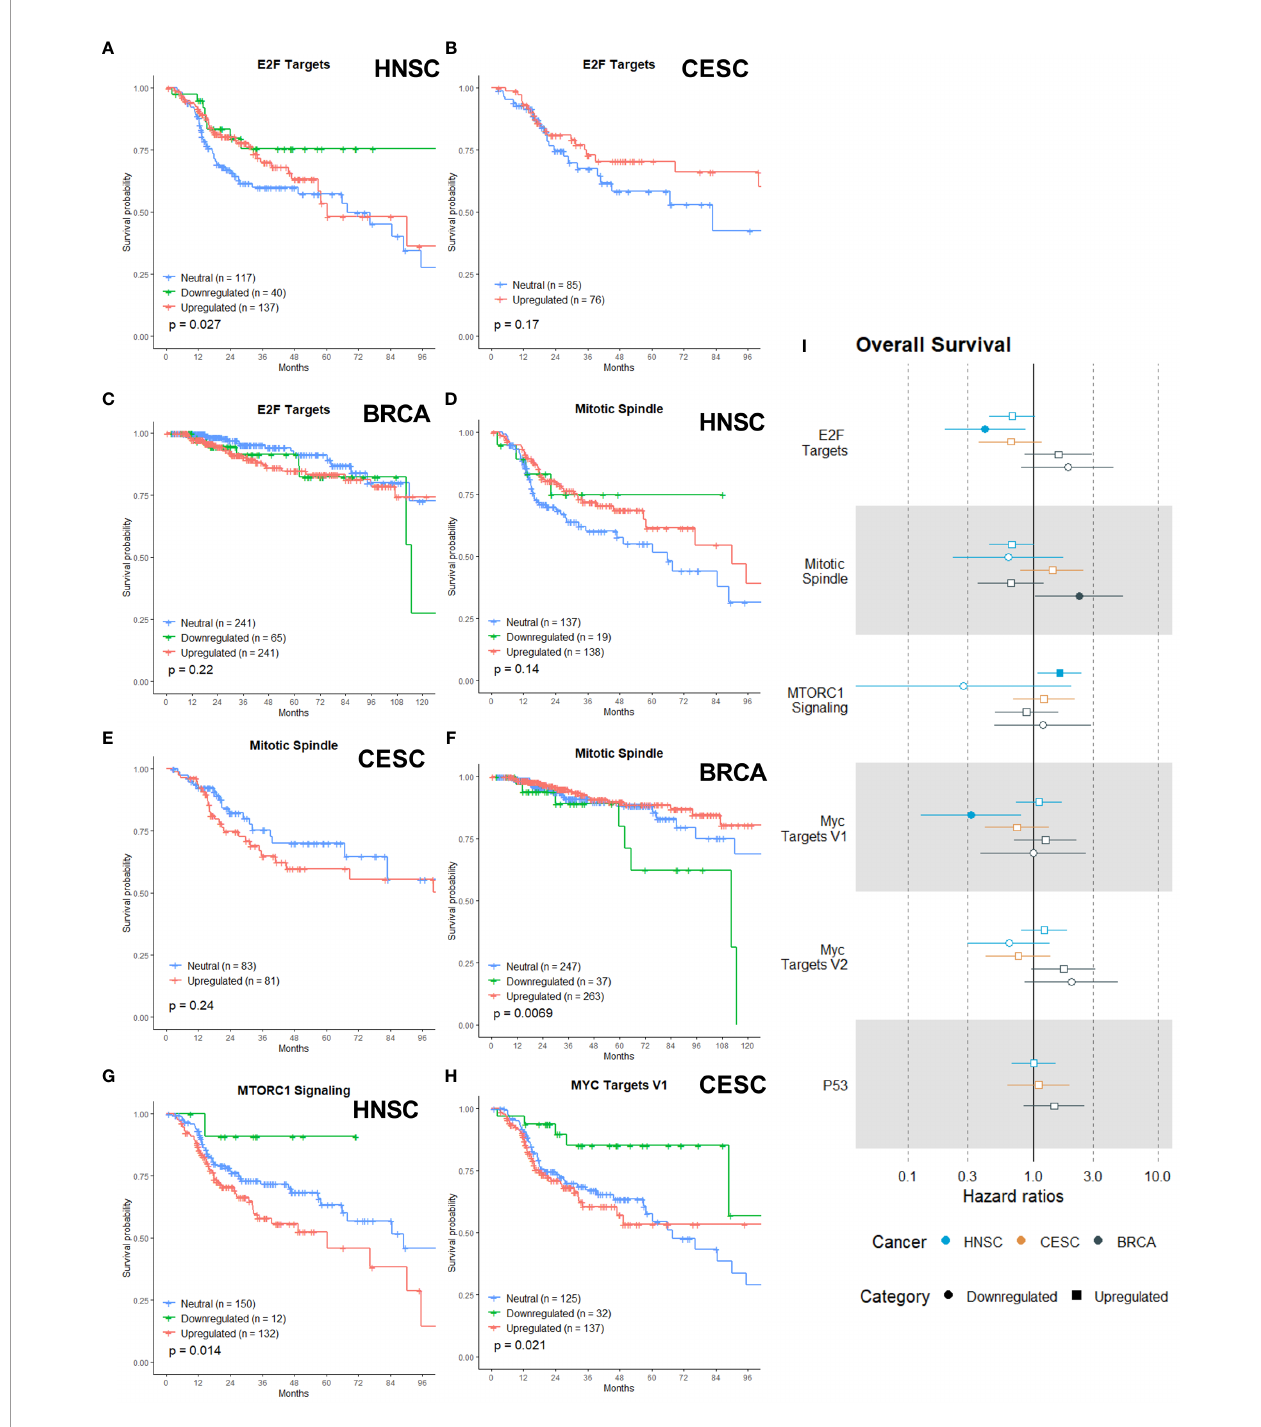
FIGURE 4 | Associations of gene sets of the Proliferation category with patient overall survival times. Kaplan-Meier plots for the E2F Targets gene set of (A) HNSC, (B) CESC and (C) BRCA patients associated with OS. Kaplan-Meier plots for the Mitotic Spindle gene set of (D) HNSC patients, (E) CESC patients and (F) BRCA patients associated with OS. (G) Kaplan-Meier plot for the MTORC1 gene set for HNSC associated with OS. (H) Kaplan-Meier plot for the MYC Targets V1 gene set for CESC patients associated with OS. (I) Forest plot showing the results from CoxPH model fi ts for OS of all the Proliferation category gene sets. Results for the HNSC patients are in blue, brown for the CSC patients and black for the BRCA patients. Upregulated gene sets are depicted with a □ symbol [closed ■ means these results are signi fi cant (p>0.05)]. Downregulated gene sets are depicted with a ○ symbol [closed ● means these results are signi fi cant